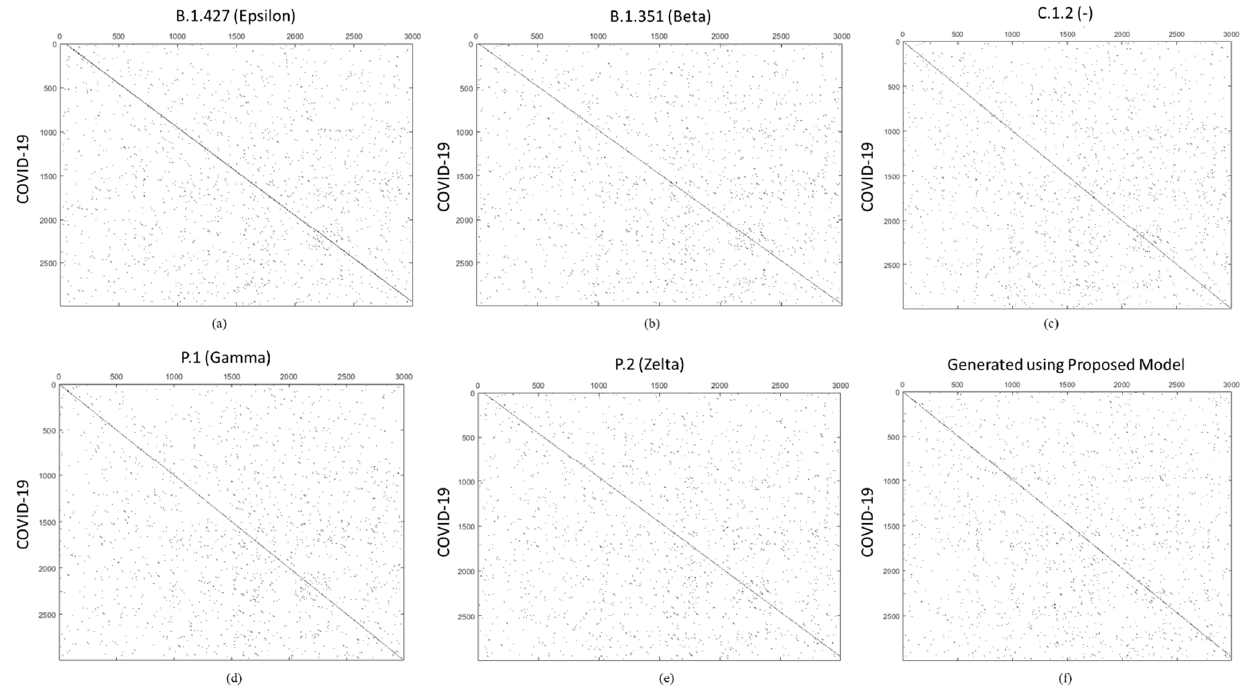
Figure 6. Dot plot similarities between nucleotide sequences of COVID-19 and its variants: ( a ) CoV-Epsilon, ( b ) CoV-Beta, ( c ) CoV-C.1.2, ( d ) CoV-Gamma, ( e ) CoV-Zeta, and ( f ) the new variant generated using the proposed technique. The number on the axis represents sequence length.